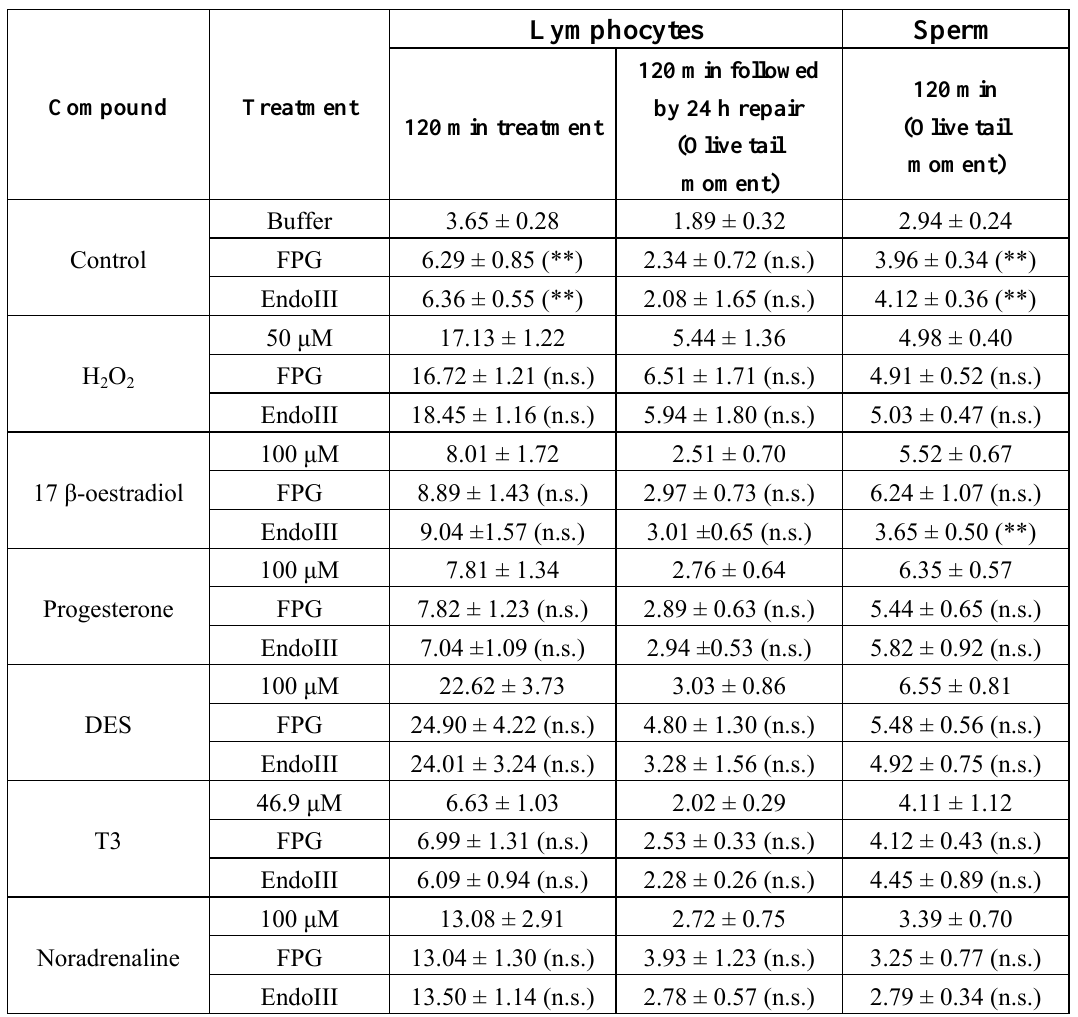
Table 1. Treatment of lymphocytes and sperm with 5 oestrogenic compounds, H the negative control with and without the presence of FPG (1:3000) and Endo III (1:3000). The table expresses the mean of the values obtained from 7 independent experiments (n = 7 different donors) for lymphocytes and 5 independent experiments (n = 5 different donors) for sperm. For lymphocytes the average age was 27.57 ± 2.41. For sperm the average age was 30.8 ± 2.35. The data were evaluated for normality with the Shapiro-Wilks test. The data were normally distributed. ANOVA with Dunnet’s post-hoc was applied. For statistical interpretation of data, treatments with FPG or EndoIII were compared to the corresponding control. The levels of significance are included: n.s.